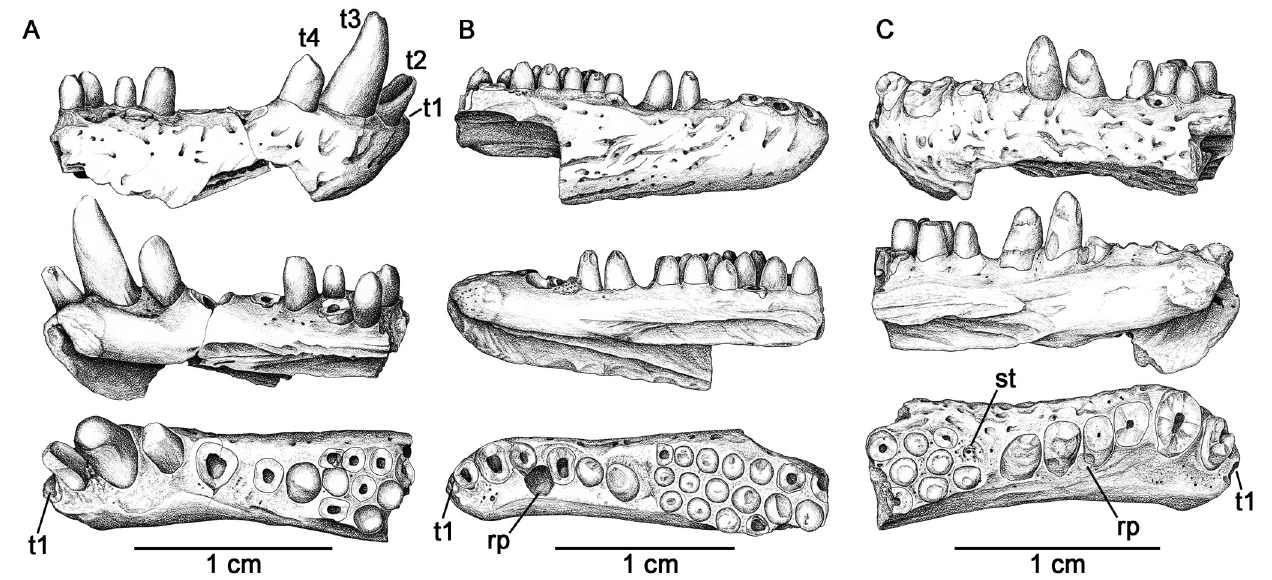
Figure 3. Three partial dentaries of Captorhinikos valensis from Bally Mountain. A, anterior portion of a right dentary (OMNH 77533) in lateral, medial, and occlusal views; B, anterior half of a right dentary (OMNH 55796) in lateral, medial, and occlusal views; C, anterior portion of a left dentary (OMNH 77534) in lateral, medial, and occlusal views. Note the presence of heavy tooth wear in the anterior portions of the multiple-rowed region. Figure 2 Previous Page. Comparisons of captorhinid jaw elements found at Bally Mountain. A, reconstruction of Captorhinus aguti showing portions of the skull represented by fossil material in grey (modified from Heaton 1979); B, partial right maxilla of C. aguti (OMNH 77541); C, SEM of ogival teeth in the multiple-rowed region of a partial dentary of C. aguti . White arrow points to the enamel crest of the tooth crown; D, posterior half of a right dentary of C. aguti (OMNH 77542); E, anterior half of a right dentary of C. aguti (OMNH 77543); F, posterior half of a right dentary of C. aguti (OMNH 77544); G, anterior half of a right dentary of C. aguti (OMNH 77545); H, reconstruction of Captorhinikos valensis showing preserved portions of the skull recovered from Bally Mountain (modified from Reisz 2006); I, posterior portion of a right maxilla of Ca. valensis (OMNH 77530); J, anterior portion of a right maxilla of Ca. valensis (OMNH 77529); K, SEM of the crown ornamen- tation of a lightly worn tooth in the multiple-rowed area of the maxilla. White arrow points to the enamel ridge that forms a ring around the tooth crown; L, posterior portion of a left maxilla of Ca. valensis (OMNH 77532); M, anterior portion of a left maxilla of Ca. valensis (OMNH 77531); N, nearly complete right dentary of Ca. valensis (OMNH 55796); O, SEM of a heavily worn maxillary tooth. Scale bars =